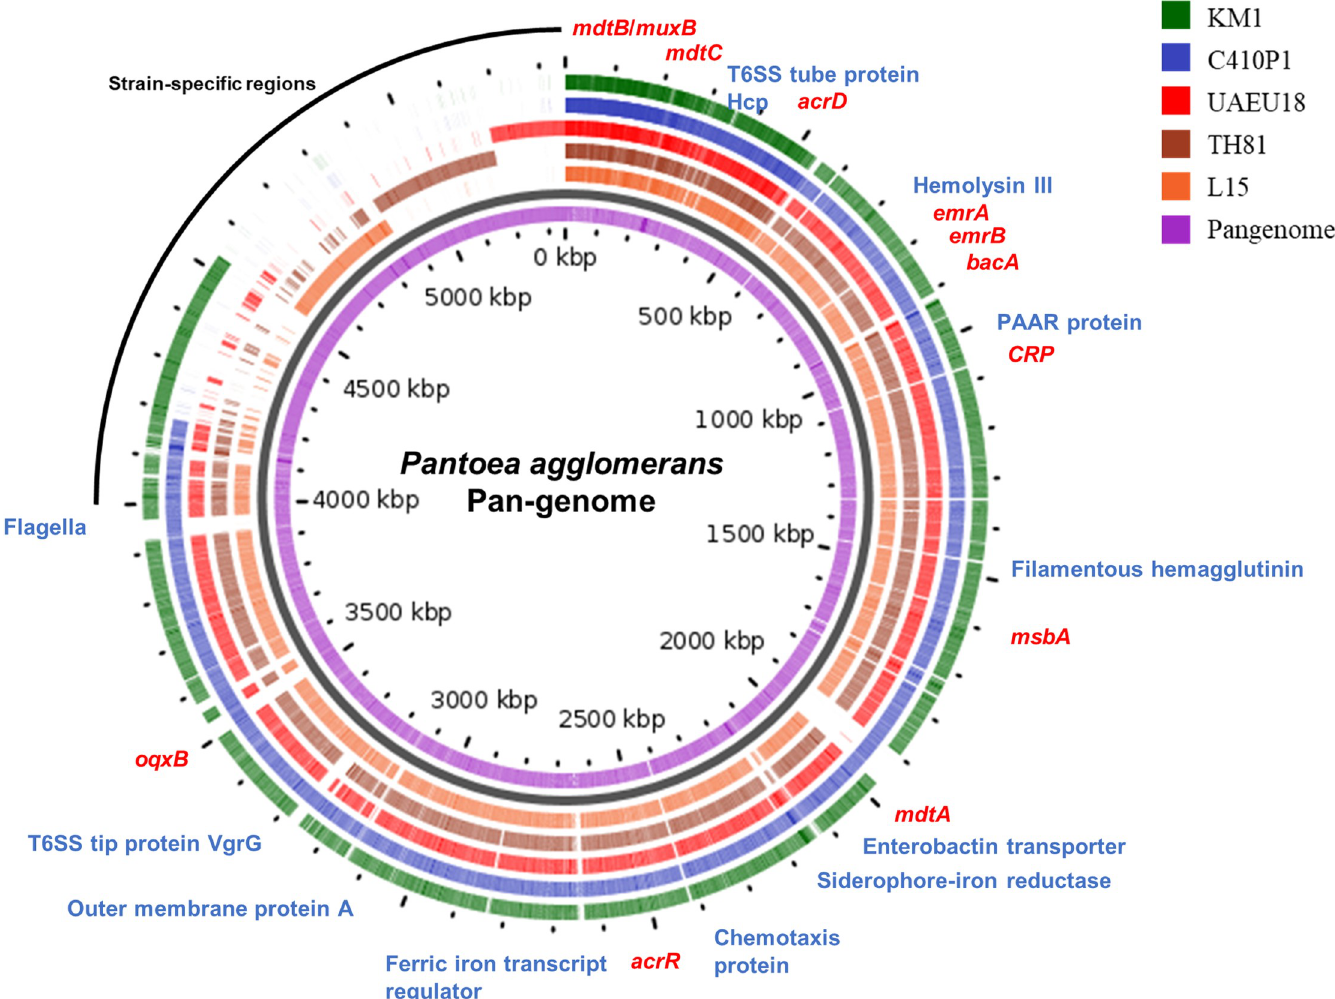
Fig 5. Pan-genome analysis of P . agglomerans strains obtained using Gview server. The innermost circle shows the pan-genome (purple), and outer circlers indicate the genomes of Pantoea agglomerans strains L15 (orange), TH81 (brown), UAEU18 (red), C410P1 (blue), and KM1 (green). Genes with specialized functions were labelled with different colors: virulence-related genes (blue), antibiotic resistance genes (red), and strain-specific regions (black).